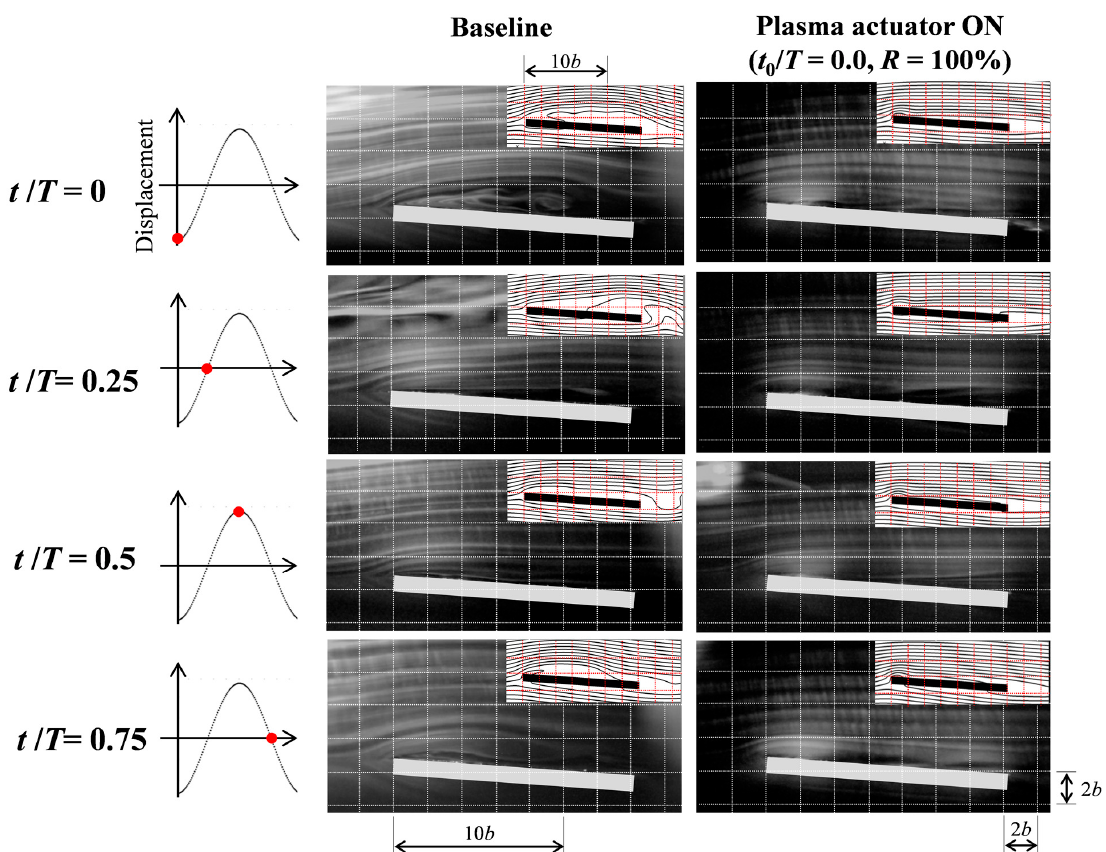
Figure 10. The visualized flow pattern and predicted streamlines (upper right in each figure) around the oscillating plate with and without control by the actuator on the top surface ( R = 100%), where T is an oscillation period and t = 0 represents the time for the bottom dead center of the oscillating